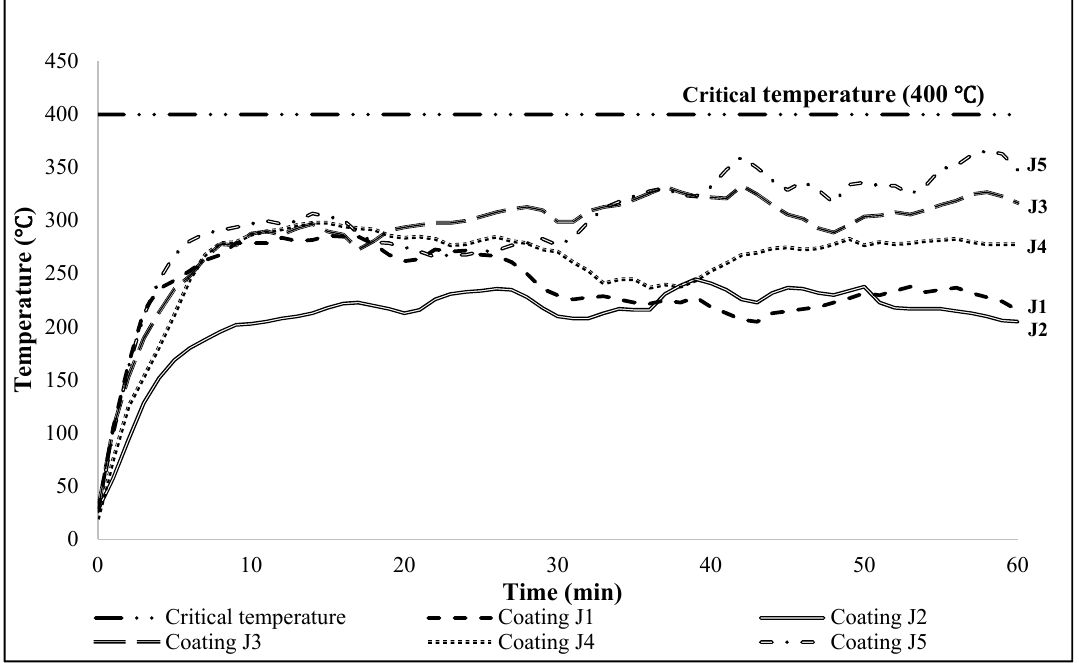
Figure 5. Evolution of temperature on the coated steel plates.